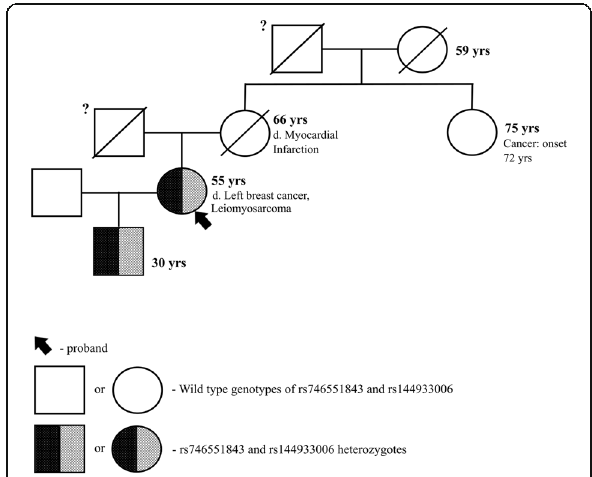
Fig. 2 Pedigree. Genetic variants that were identified in the patient were tested in the aunt by maternal lineage and